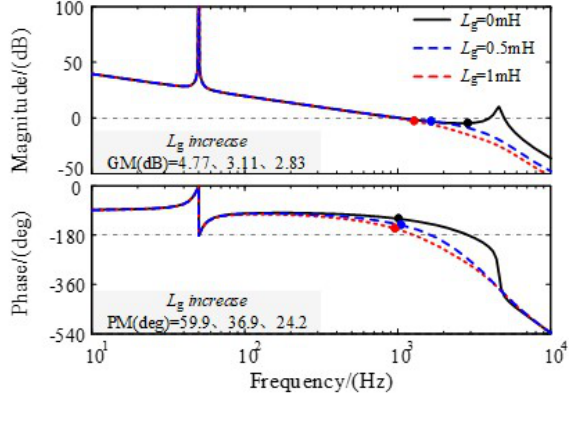
Fig. 15. Bode diagram of T CCFAD2 ( s )